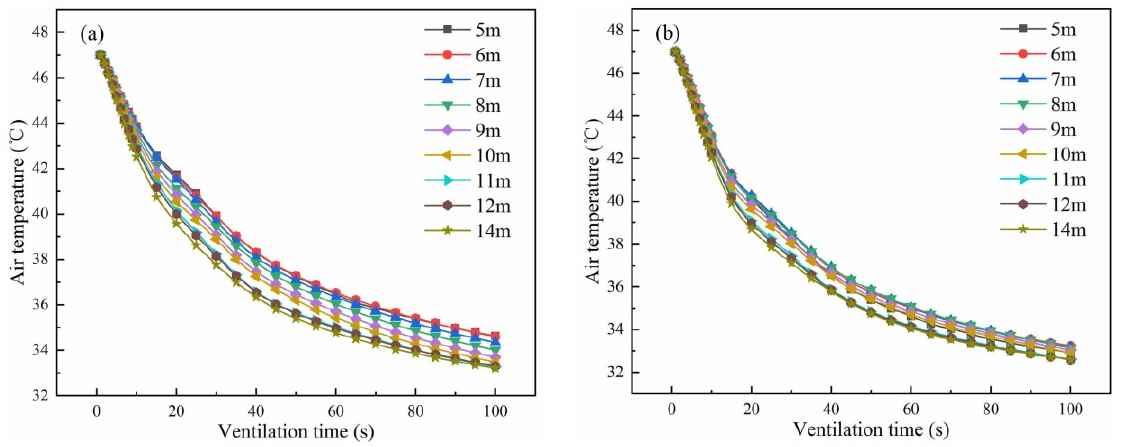
Figure 14. Cooling rate of the clustered solar greenhouse under different building spacings: ( a ) the second row; ( b ) the third